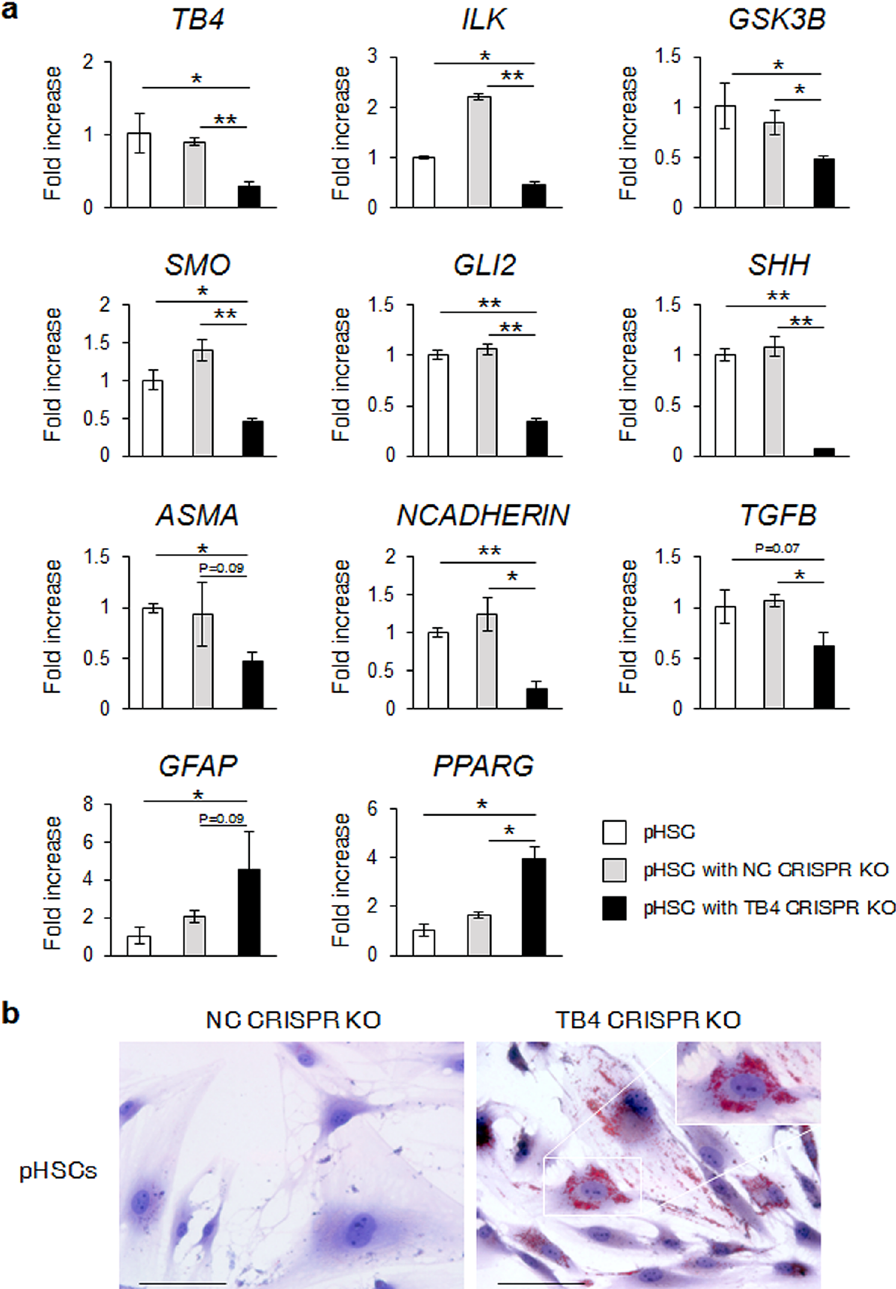
Figure 5. CRISPR/Cas9-mediated TB4 knockout down-regulates Hh expression and promotes inactivation of human primary HSCs. ( a ) qRT-PCR of TB4, ILK, GSK3B , Hh signaling ( SMO , GLI2 , and SHH ), markers of HSC activation (A SMA , NCADHERIN , and TGFB ) and markers of HSC inactivation ( GFAP and PPARG ) in human pHSCs transfected with non-targeting control knockout CRIPSR/Cas9 plasmid (NC CRISPR KO; gray bar) or TB4 knockout CRISPR/Cas9 plasmid (TB4 CRISPR KO; black bar). Expression of these genes expression in nontreated pHSCs was marked as white bar. Results of relative expression values are shown as mean ± s.e.m. of triplicate experiments ( * p < 0.05; ** p < 0.005.) ( b ) Oil red O staining for lipid droplets in these cells (original magnification × 40, Scale bar, 100 μ m). Inserted image presents the magnified image ( × 63). Representative images from three experiments are